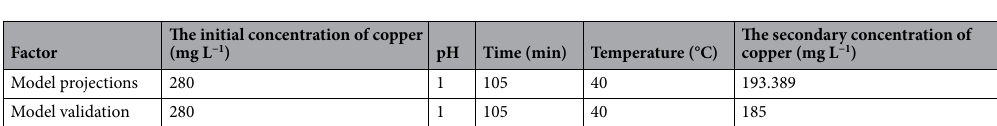
Table 7. The proposed levels of parameters studied to minimize the secondary concentration of Cu (II) and validation of laboratory experiments.